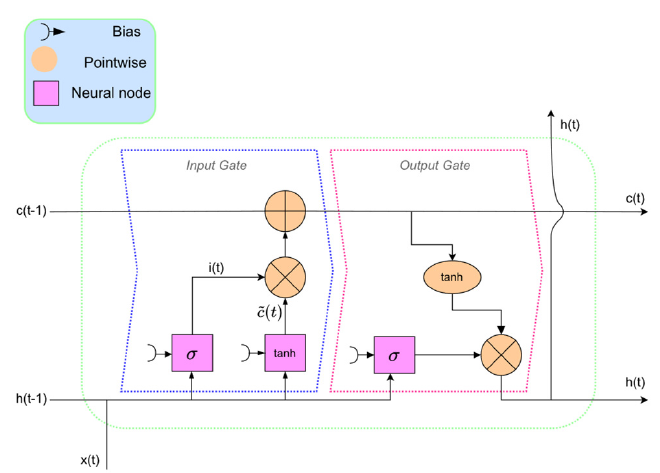
Figure 3. The architecture of long short − term memory (LSTM).